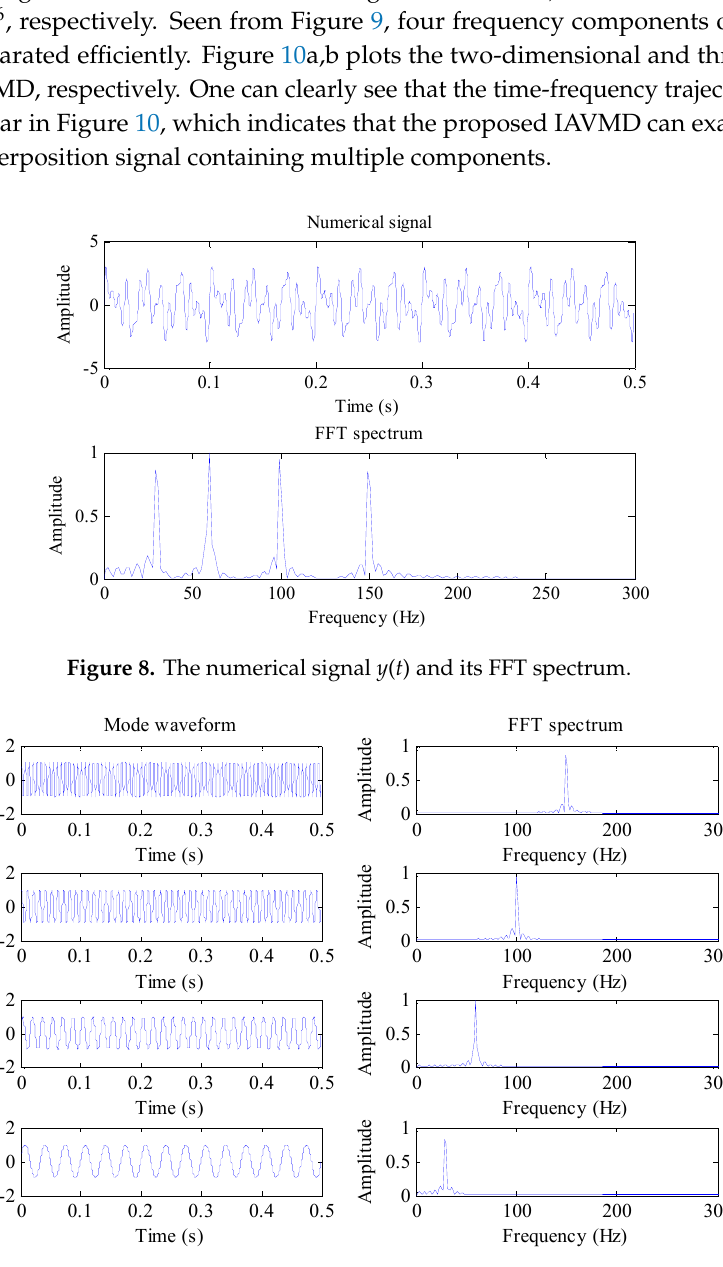
Figure 10. The time-frequency representations obtained by IAVMD for simulation 1: ( a ) Two-dimensional and ( b ) three-dimensional.